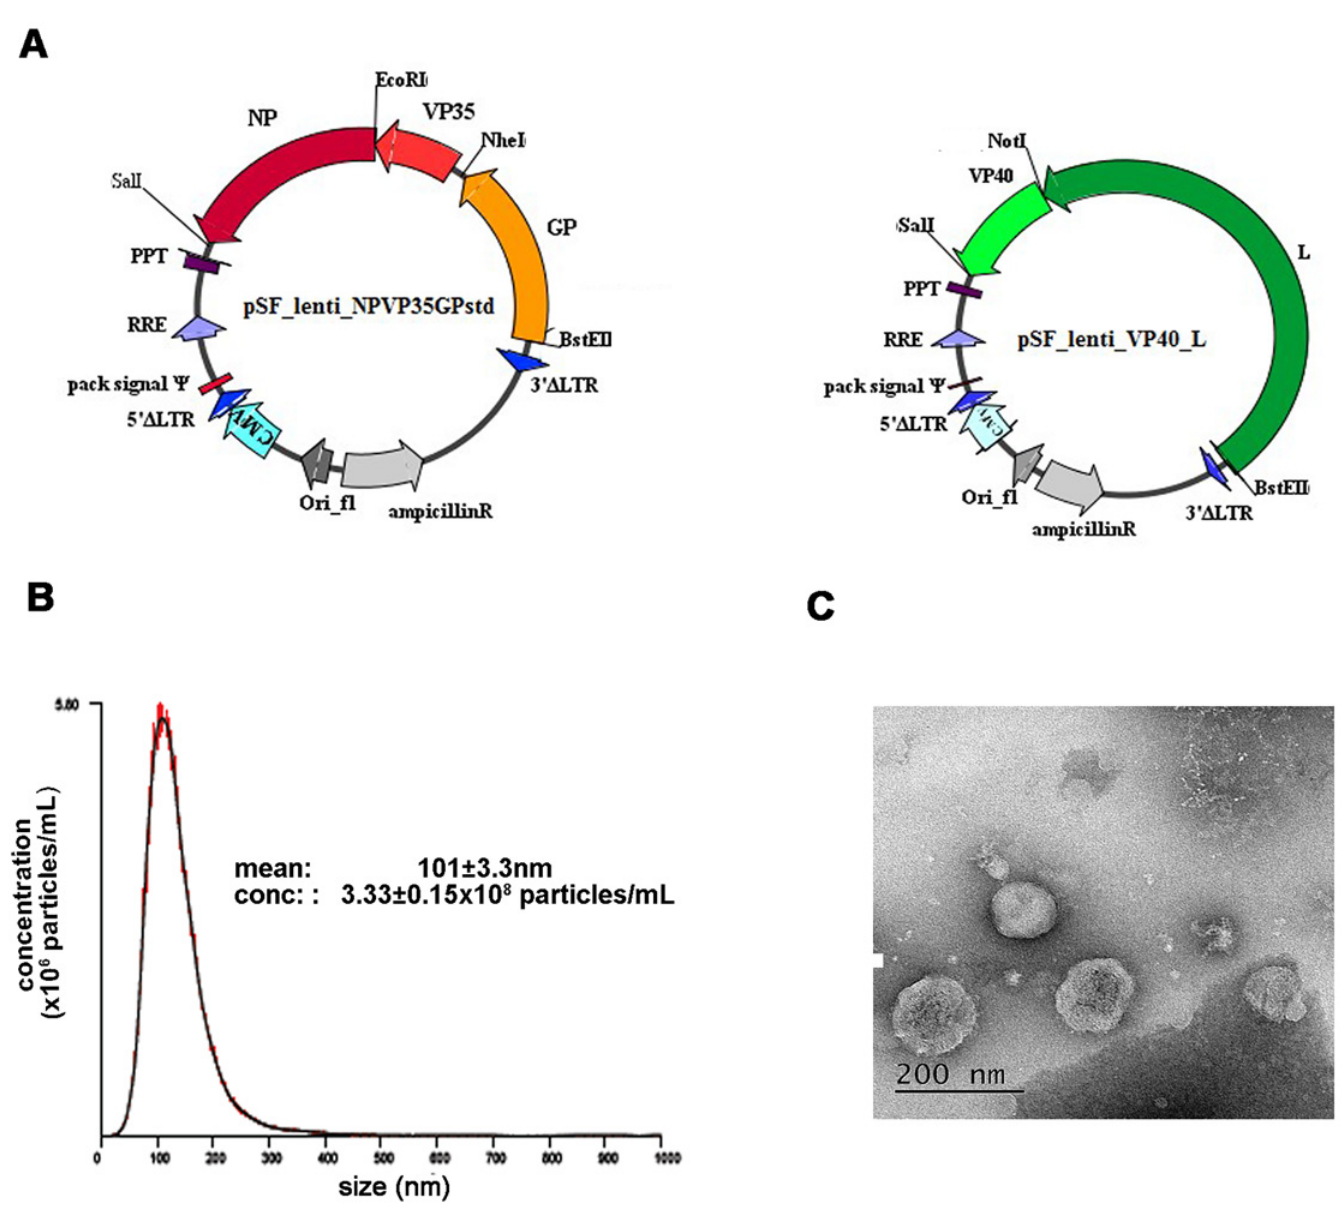
Fig 1. Generation of lentiviral particles containing Ebola virus RNA. A) Ebola virus genes nucleoprotein (NP, dark red), viral protein 35 (VP35, red), glycoprotein (GP, orange), viral protein 40 (VP40, light green) and the polymerase encoding gene L (dark green) were sequentially cloned into lentiviral vector pSF_lenti between the restriction sites SalI and BstEII. The main elements of the lentiviral vector used for the production of the viral RNA and incorporation within HIV-like particle are indicated. B) Particle size distribution of the 1:100 dilution in PBS of stock preparation of lentiviral particles containing Ebola virus RNA for np-vp35-gp genes. The graph represents the mean of 5 acquisitions (black line) ± standard deviation (red line). C) A representative image of the same preparation diluted 1:10 in PBS analysed by negative staining transmission electron microscopy. The average particle size was 116.02 nm (average of 9